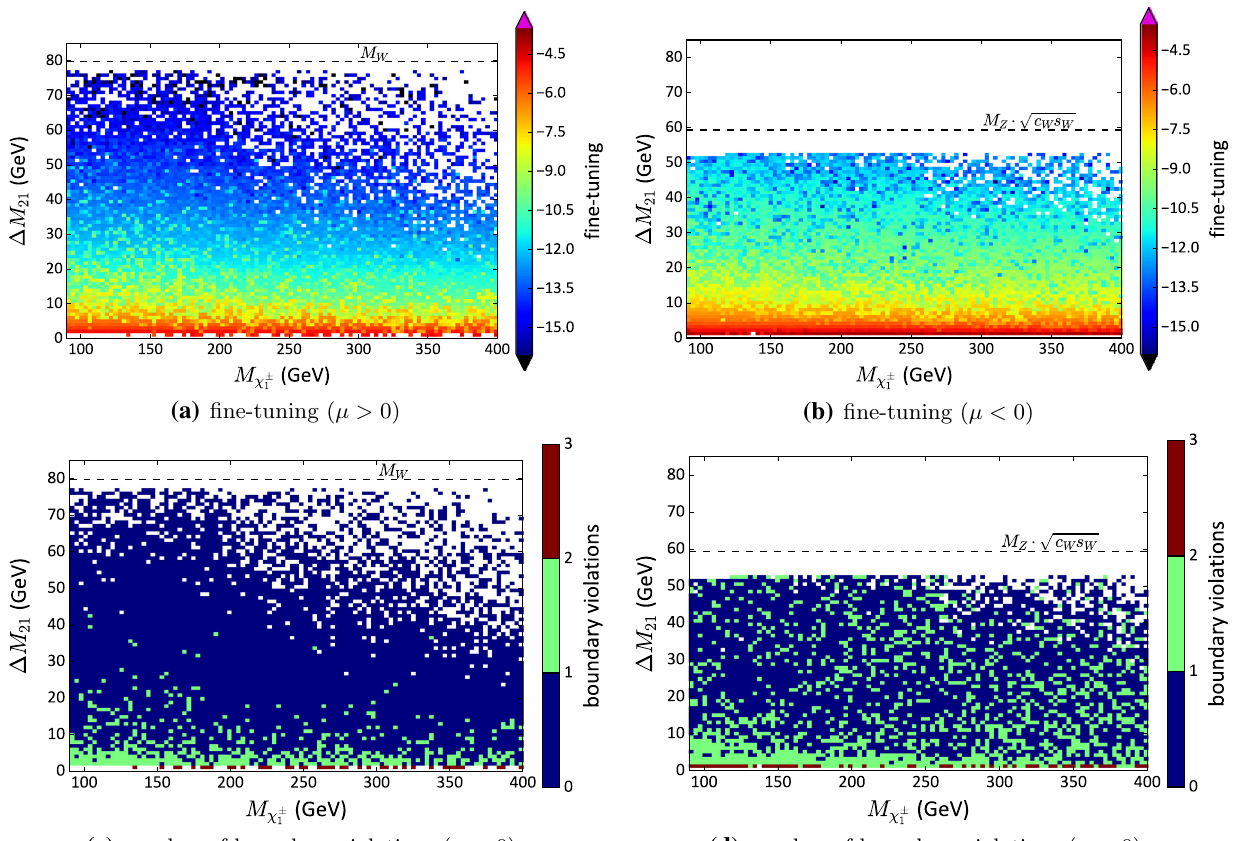
Fig. 6 Upper figures: logarithmic representation of the fine-tuning level of simplified light higgsino models in terms of the relative accept- able ranges of the underlying MSSM parameters for μ > 0 ( a ) and μ < 0 ( b ). Large negative numbers therefore indicate large fine-tuning. Lower figures: number of boundary violations of the initial parameter